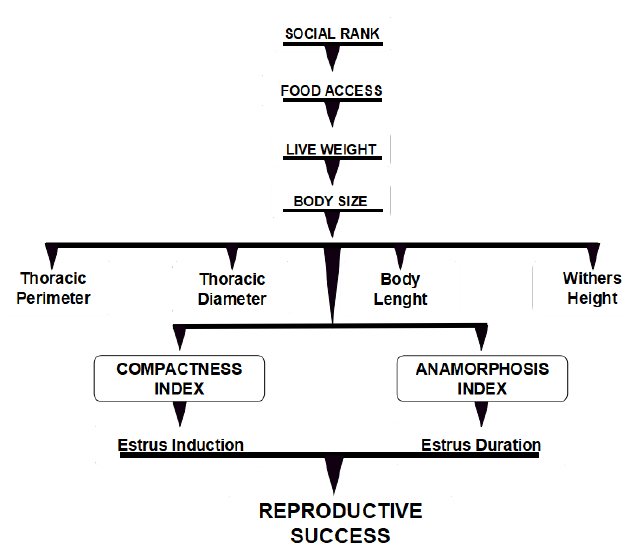
Figure 5. Conceptual diagram modeling the main relationships among social rank, food access, live weight, body size, morphometric values, morphologic indexes, estrus induction, estrus duration, and reproductive success in crossbred (Alpine-Saanen-Nubian × Criollo; n = 70) anestrous dairy goats managed under intensive stall fed conditions in Northern Mexico (March, 25° North).